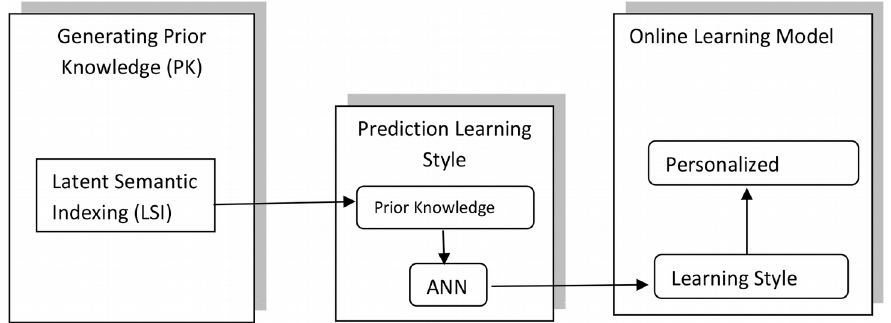
Figure 1. Methodology research